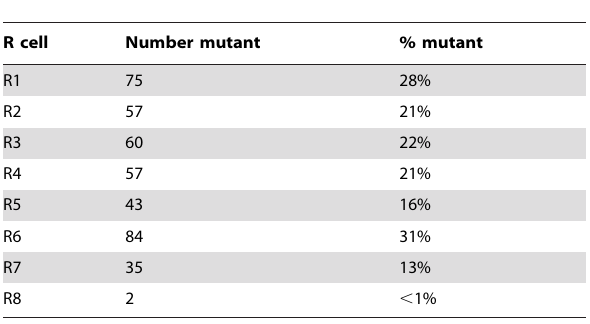
Table 1. Analysis of adult retina mosaic for rux 8 .